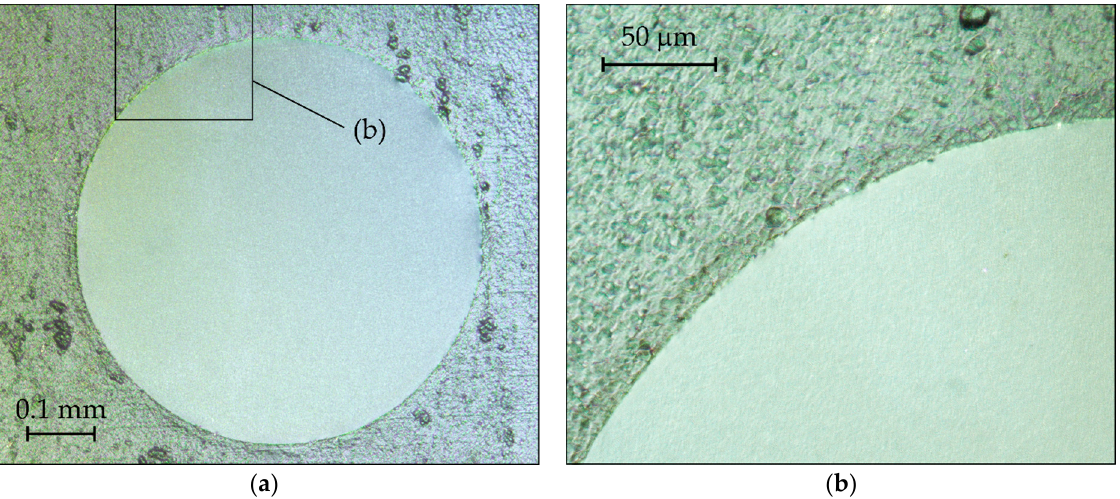
Figure 7. Microscope images of a typical Ti/Pt diaphragm supported by a commercial pure cold- rolled Ti plate: ( a ) image taken at a magnification of 100×; ( b ) zoomed view on the edge region of rolled Ti plate: ( a ) image taken at a magnification of 100 × ; ( b ) zoomed view on the edge region of the the diaphragm (magnification 200×). diaphragm (magnification 200 ×